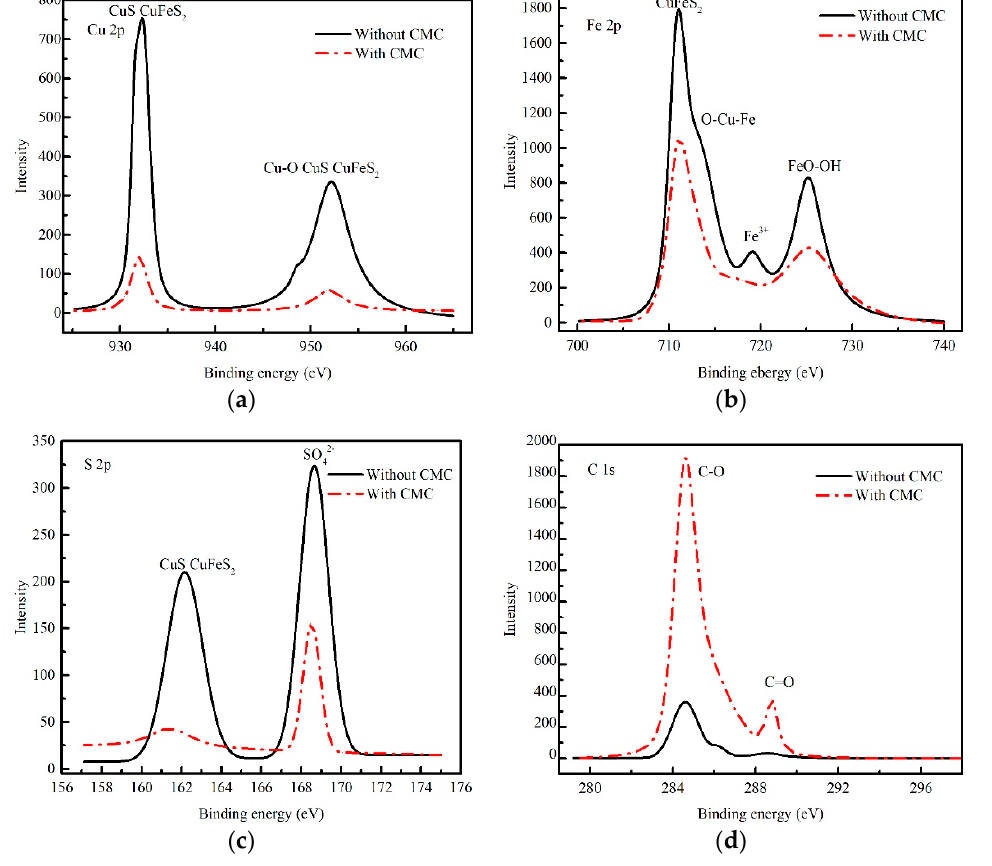
Figure 8. XPS analyses of chalcopyrite elements before (black) and after (red) treatment with CMC. ( a ) Cu 2p; ( b ) Fe 2p; ( c ) S 2p; ( d ) C 1s.